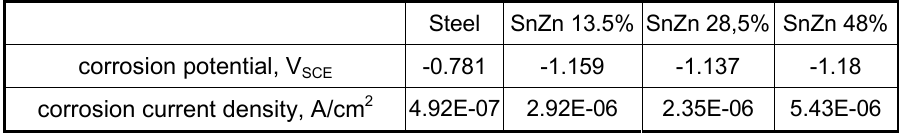
Table 3 – Comparison of the corrosion parameters of Sn-Zn layers obtained from different pyrophosphate baths (corrosion medium: 3 wt. % NaCl solution at room temperature) Таблица 3 – Сравнение коррозийных параметров покрытия из сплавов цинка и олова , полученных из различных пирофосфатных ванн ( коррозийная среда : 3 вес % раствор NaCl при комнатной температуре